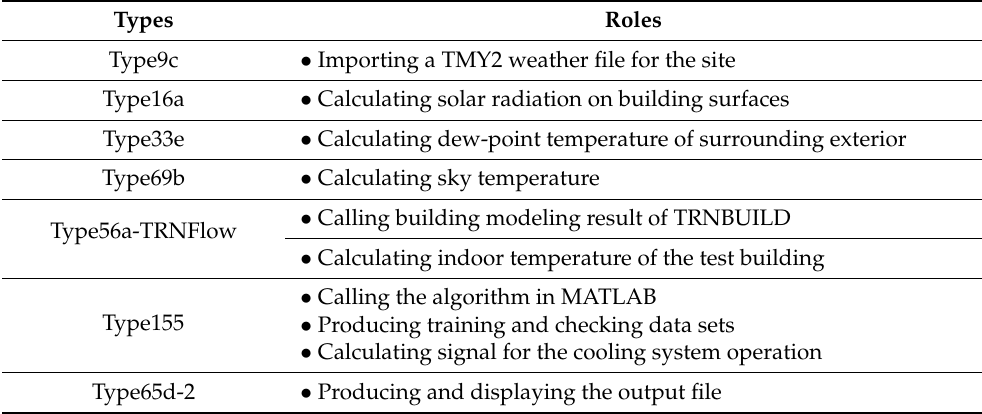
Table 4. Modeling result and TRNSYS types and roles employed.